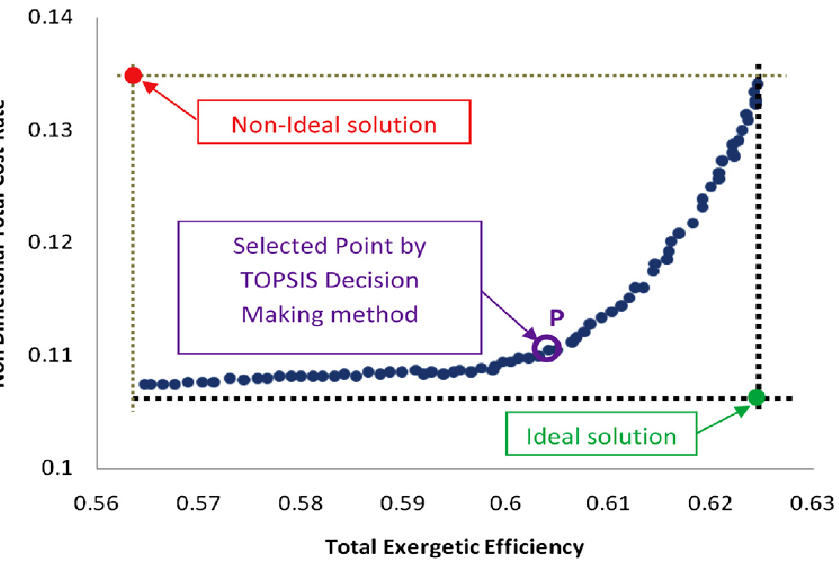
Figure 9. Selecting the optimum point from pareto frontier, representative of the best compromise, between the total cost and total exergetic efficiency of CHP plant, using TOPSIS decision making method [140].